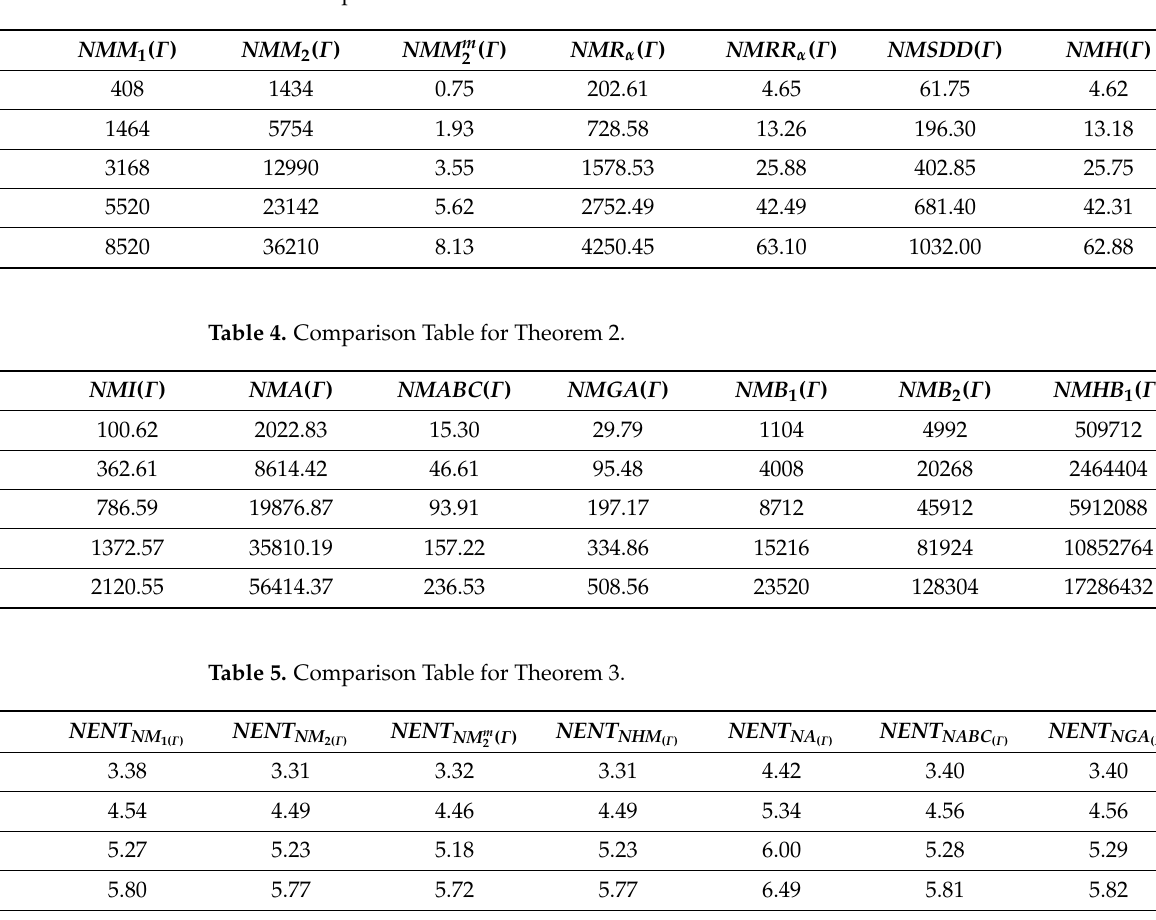
Figure 3. 3D Plots for Table 3. Table 3. Comparison Table for Theorem 2.